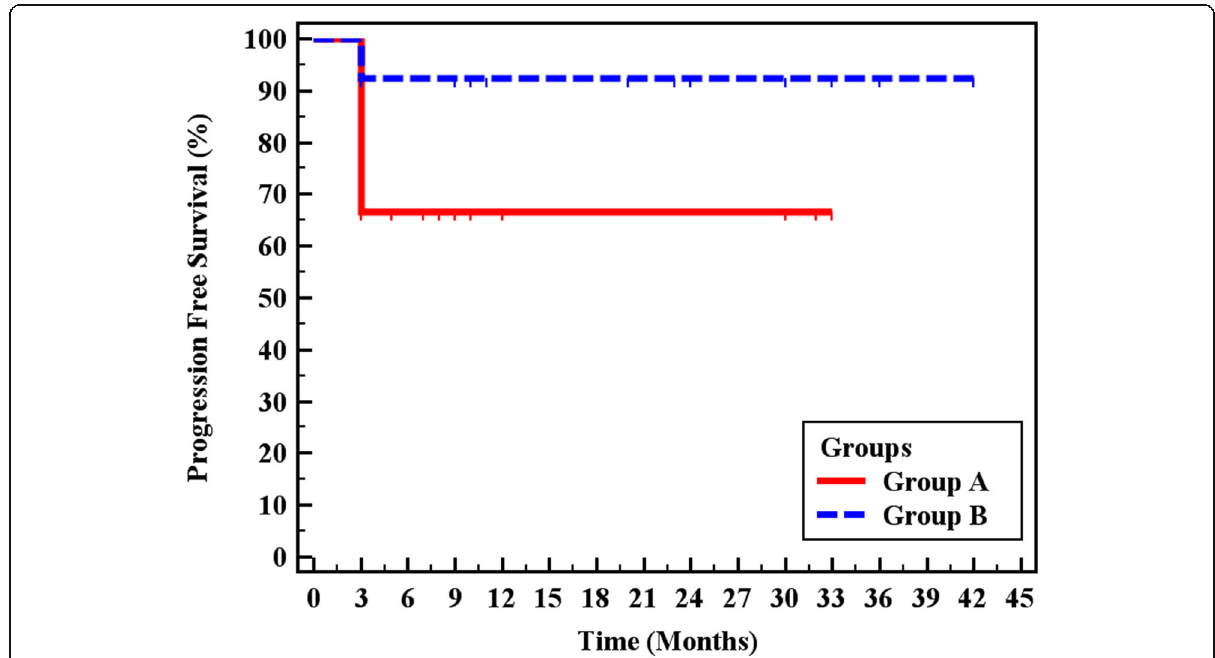
Fig. 1 Kaplan – Meier survival curve for progression-free survival for group A and group